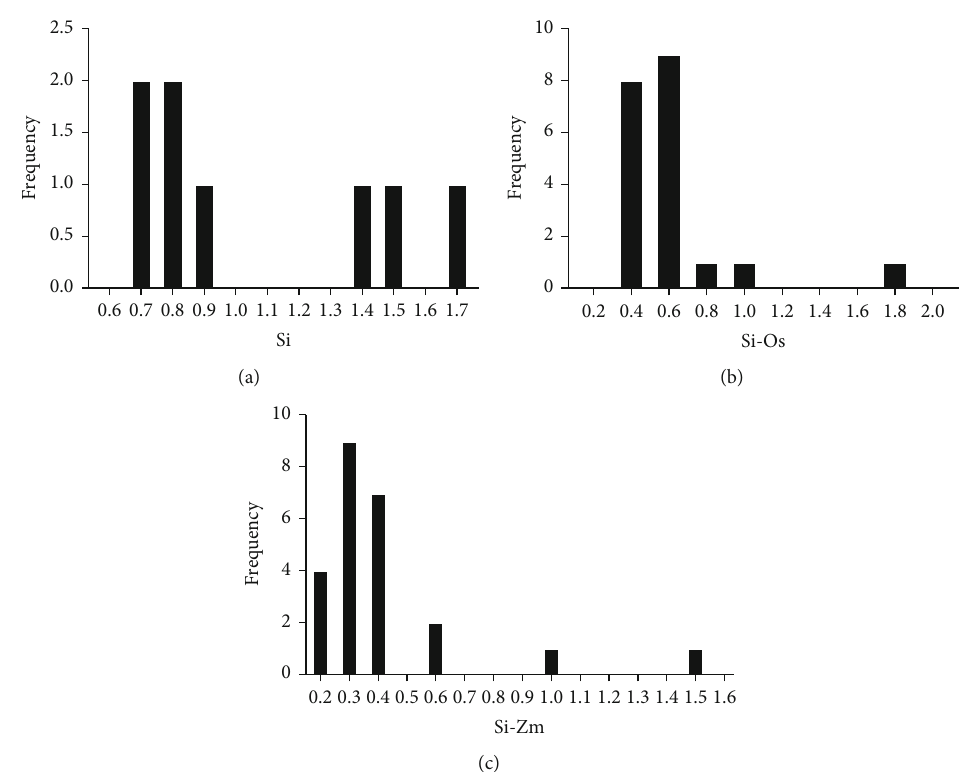
Figure 3: Ks distribution of paralog pairs of SiARFs. (a) Orthologous pairs between S. italica and Oryza sativa and between S. italica and Zea mays , respectively. The x -axis represents the Ks values of paralogous or orthologous gene pairs and was divided into di ff erent parts in unit of (a) 0.1 or (c) 0.2. (b) The y -axis means the frequency of Ks value relative to each unit. Si represents ARF paralogous in S. italica ; Si-Os represents ARF orthologous between S. italica and O. sativa ; Si represents ARF orthologous between S. italica and Z. mays